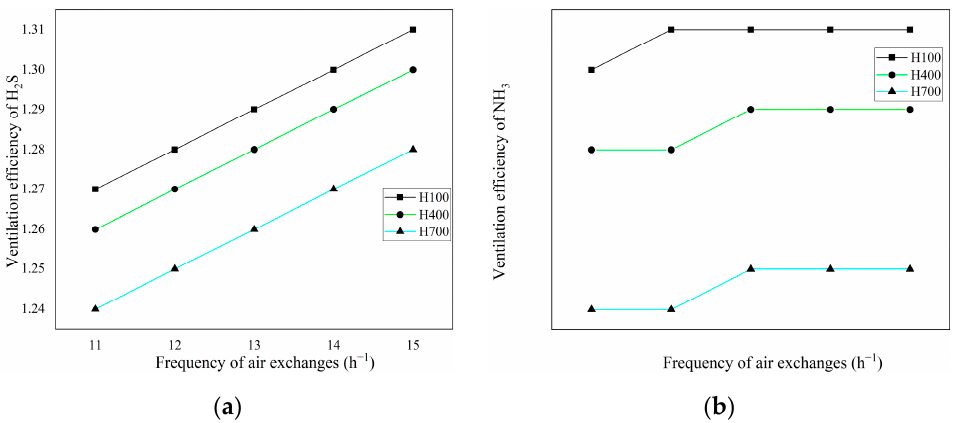
Figure 13. The relationship between ventilation efficiency and the frequency of air exchange. ( a ) Ventilation efficiency of H 2 S; ( b ) Ventilation efficiency of NH 3 .